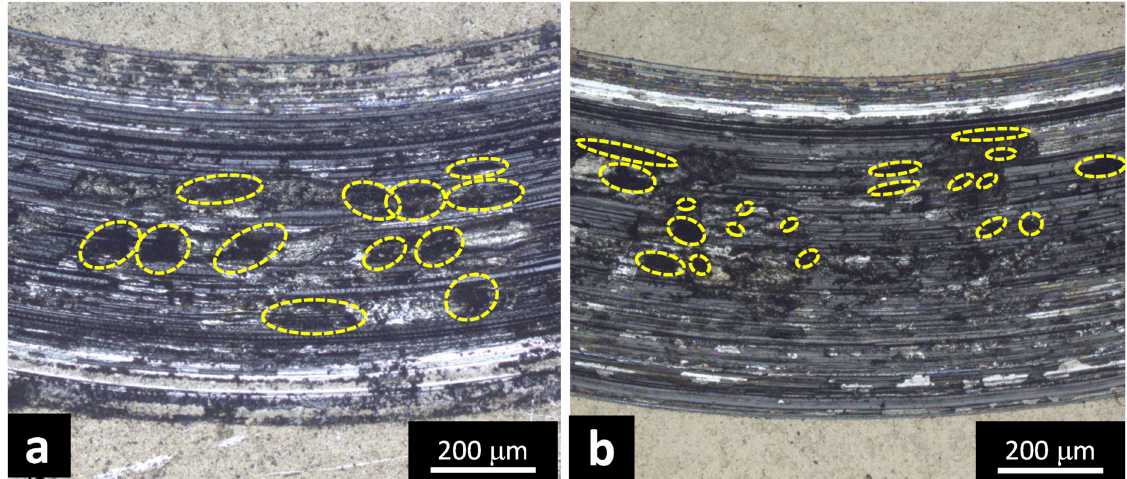
Figure 9. Morphology of the worn track on the simply ( a ) and the duplex-coated sample ( b ) with Fe 3 O 4 islands on the damaged